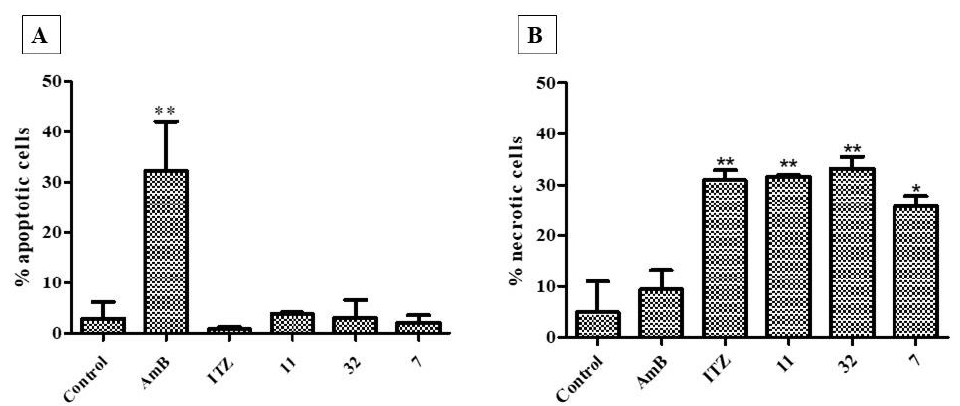
Figure 12. Mechanism of death due to apoptosis ( A ) and necrosis ( B ) induced after treatment of H. capsulatum EH-315 with 7 , 11 , and 32 , in addition to the drug controls AmB and ITZ, compared with the untreated control. The AmB induced cell death by apoptosis, whereas ITZ, 7 , 11 , and 32 induced death by necrosis. * p < 0.05; ** p <